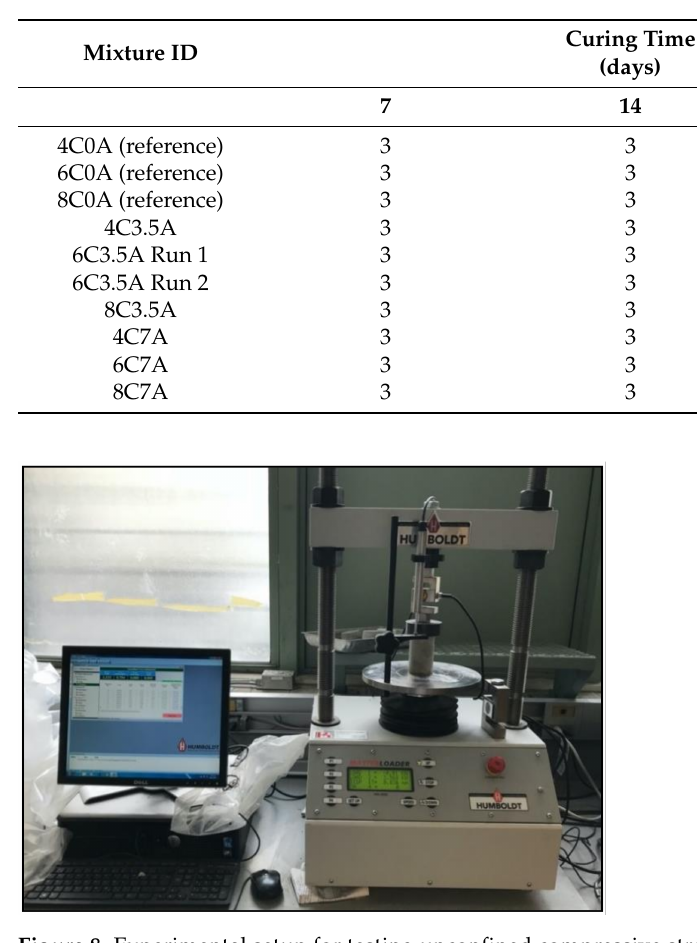
Figure 8. Experimental setup for testing unconfined compressive